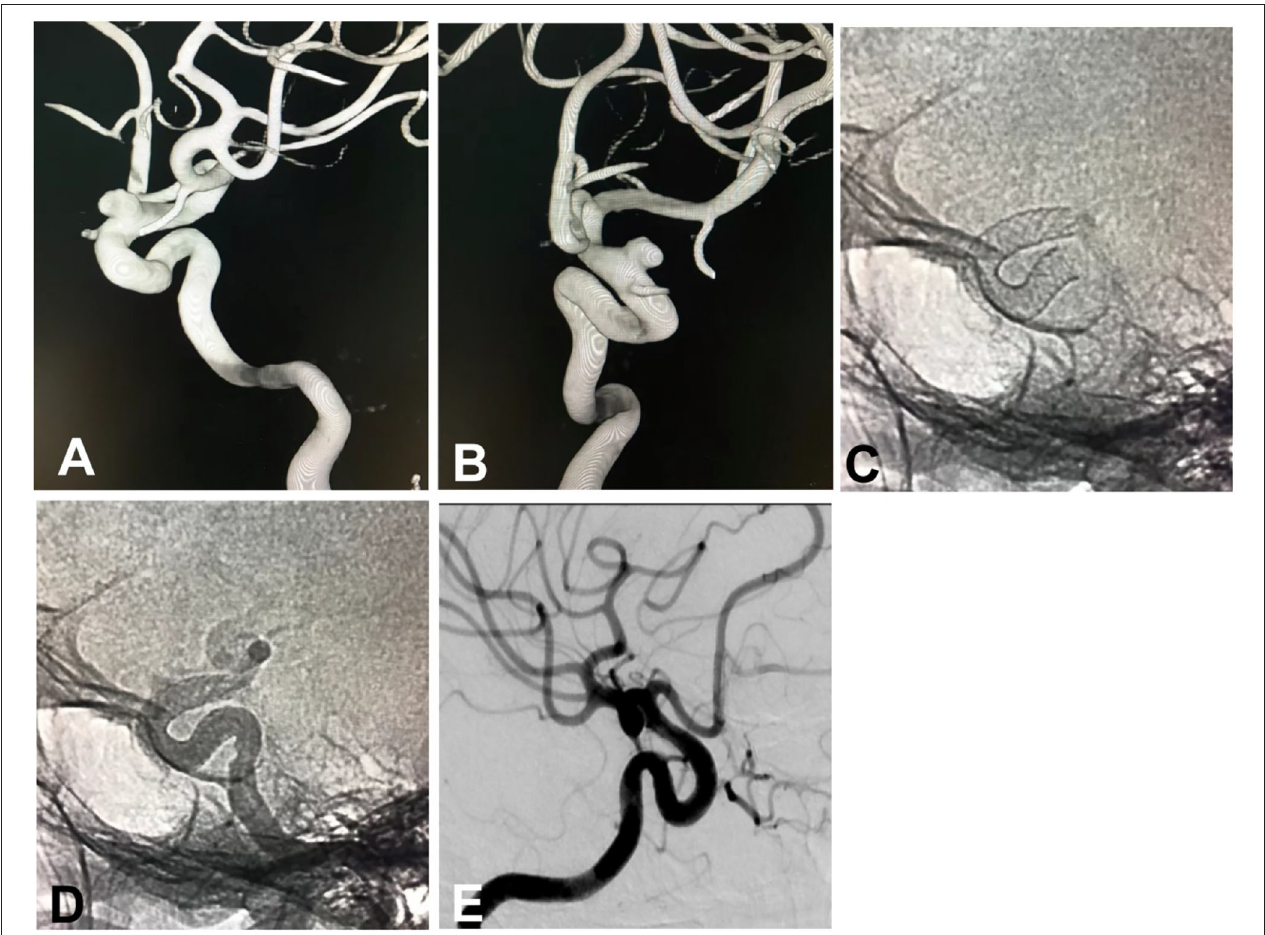
FIGURE 1 | A small intracranial aneurysm in a 53-year-old woman with dizziness was treated with the deployment of a Pipeline embolization device. (A,B) The small aneurysm was located at the sixth (ophthalmic) segment of the left internal carotid artery, measuring 5.1 × 3.0mm in the sac with a 4-mm neck. (A) Lateral position, (B) Oblique position. (C) Immediately after deployment of a Pipeline device of 4.25 × 20mm, the stent was shown to have a good opening on angiography. (D) Angiography immediately following the deployment of the stent, the parent artery was shown to be patent with good wall adherence of the stent. (E) Follow-up angiography 8 months later revealed patent parent artery and complete occlusion of the